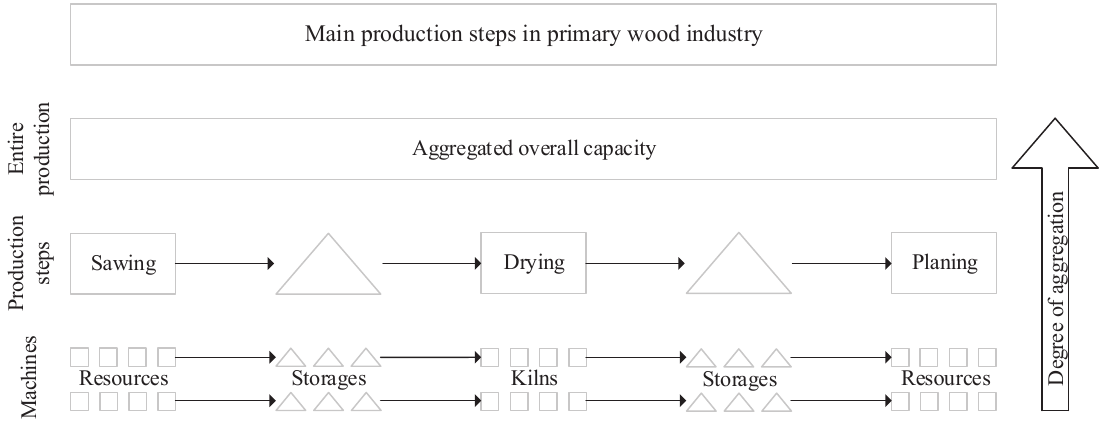
Figure 1. Process view at possible aggregation stages in production planning models of the primary wood